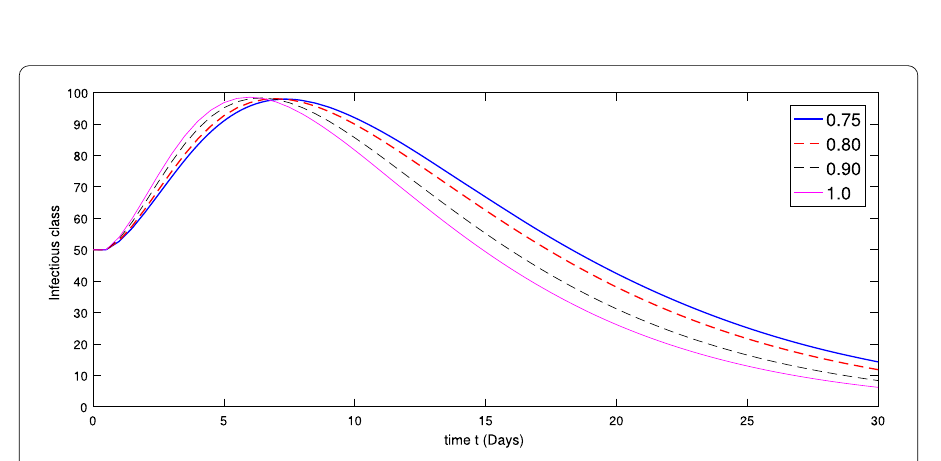
Figure 5 Graphical representation of approximate solutions up to five terms of infected population I ( t ) at different fractional order of the considered model